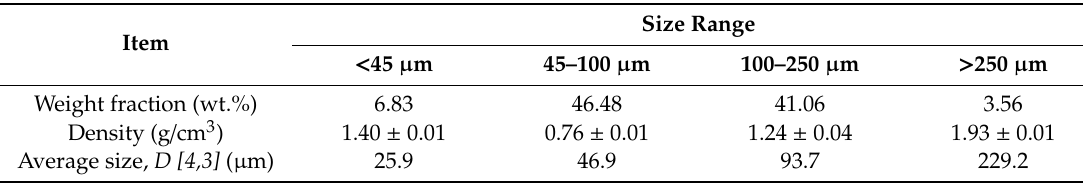
Table 4. Properties of cenospheres with various